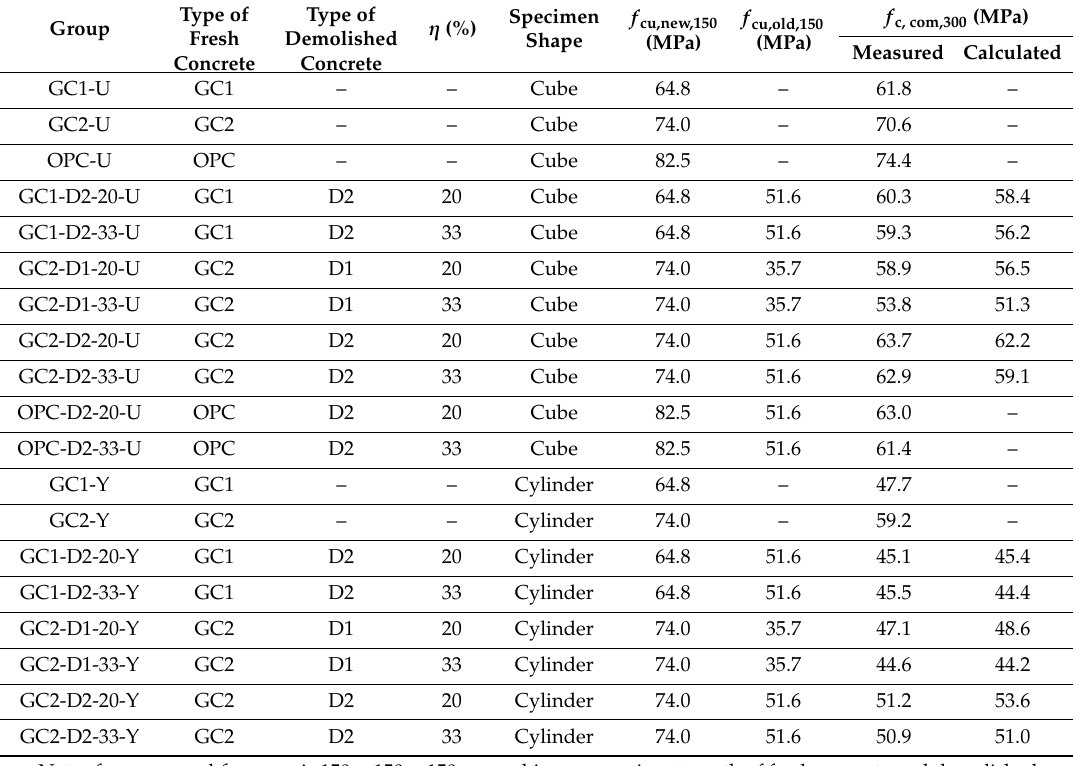
Figure 2. Preparation of geopolymer recycled lump concrete (GRLC) specimens, ( a ) Preparation process flowchart of GRLC specimens. ( b ) Fresh geopolymer concrete (GC) layer. ( c ) Vibration. ( d ) Specimens molding. Table 4. Details of